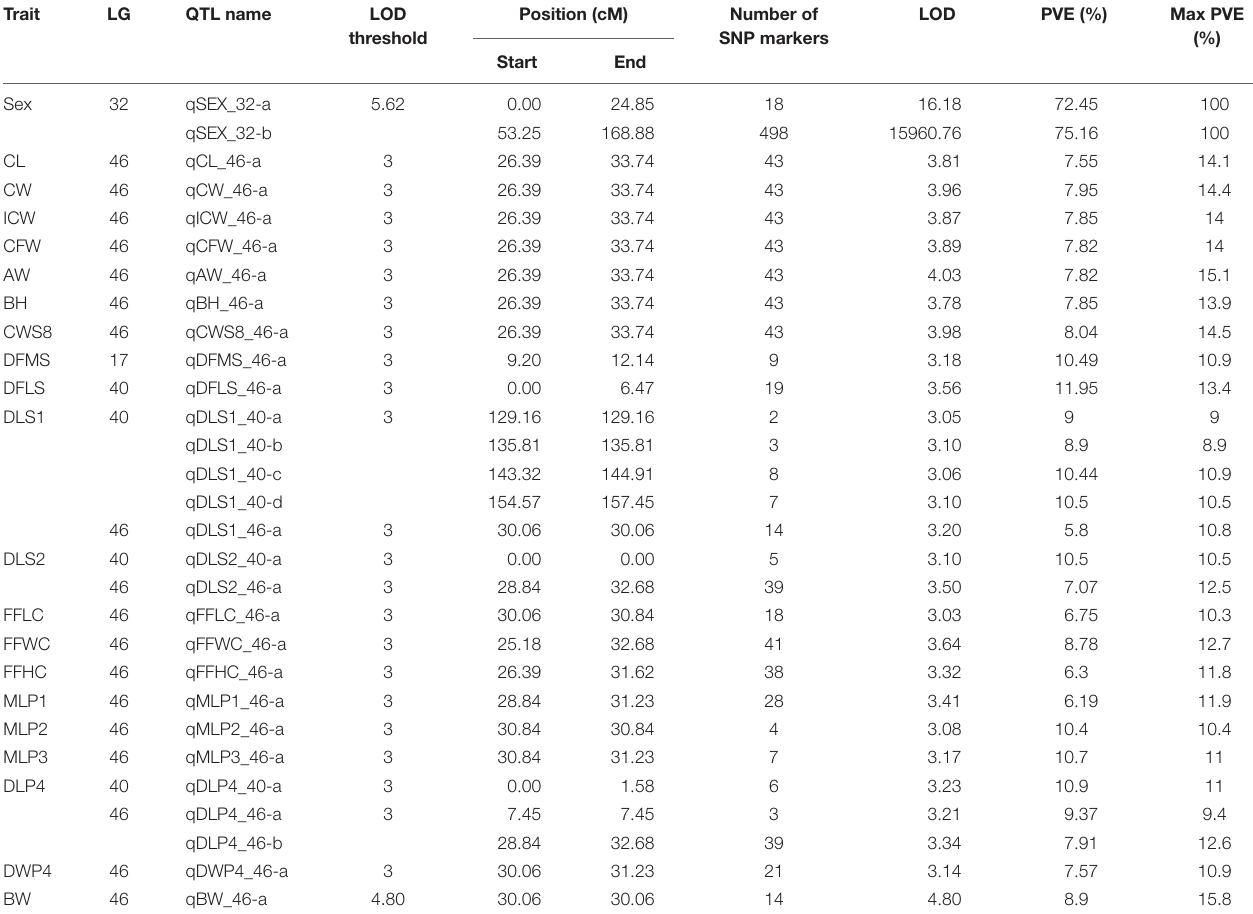
TABLE 3 | Quantitative trait loci (QTLs) for sex and growth-related traits of Scylla paramamosain . Trait LG